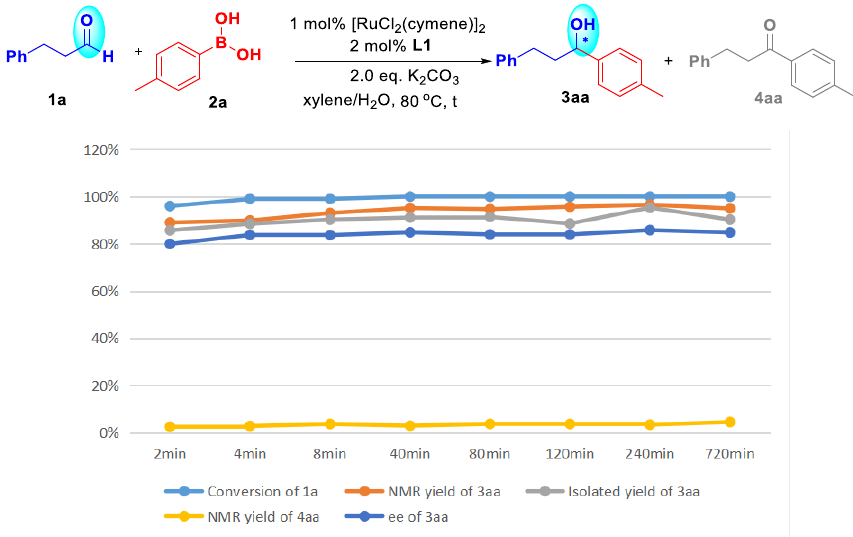
Molecules 2022 , 27 , x FOR PEER REVIEW Scheme 7. Plots for relationship of time, yield and enantioselectivity. Scheme 7. Plots for relationship of time, yield and enantioselectivity.